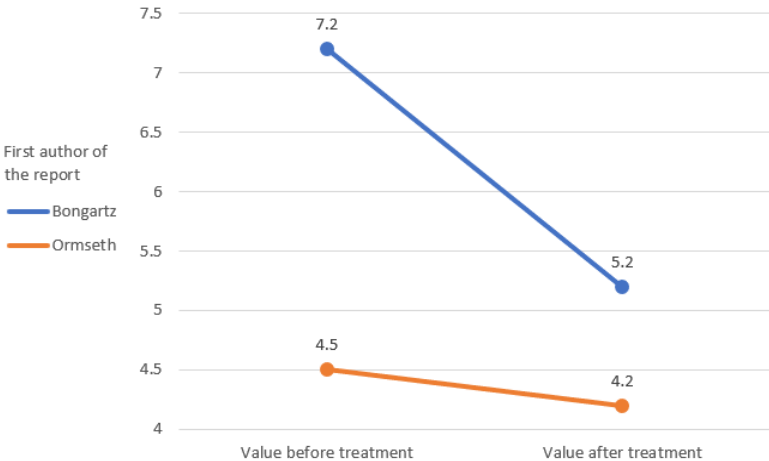
Figure 5. Initial and final values of erythrocyte sedimentation rate (ESR) [mm/h].